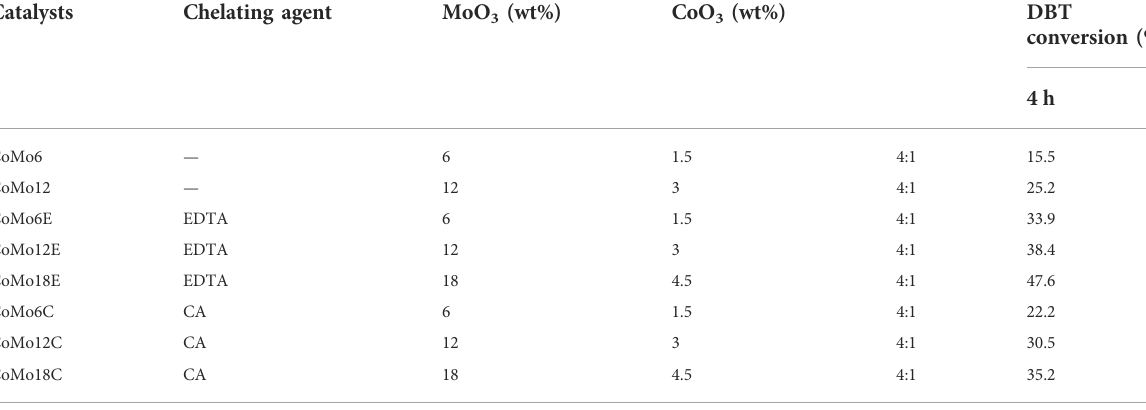
TABLE 2 Catalysts with and without chelating agents and their overall DBT conversions.